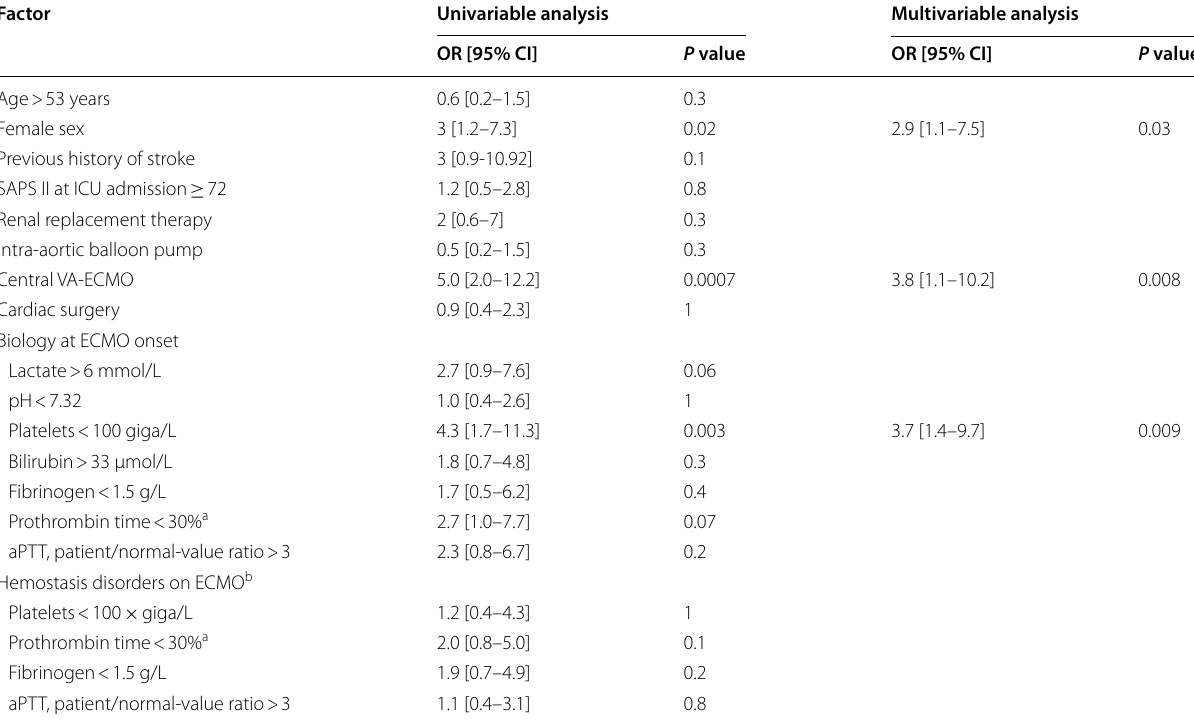
VA-ECMO venoarterial-extracorporeal membrane oxygenation, OR odds ratio, SAPS Simplified Acute Physiology Score, ICU intensive care unit, APTT activated partial thrombin